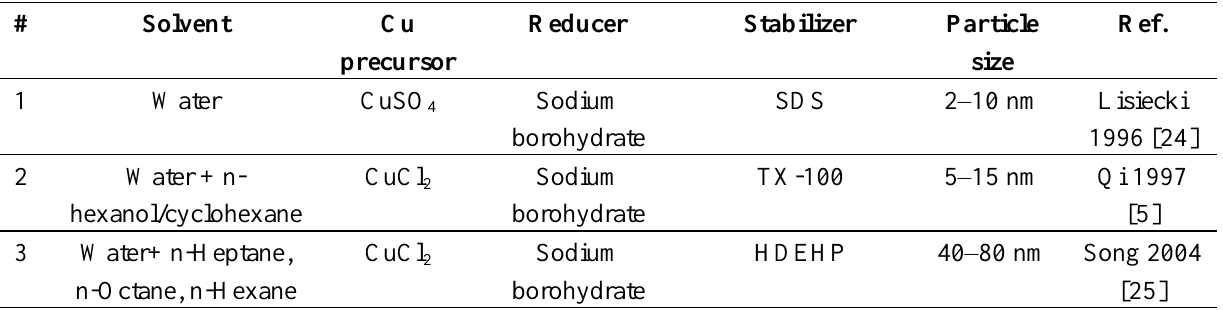
Table 1. A l ist of published methods to synthesize copper NPs by chemical reduction in